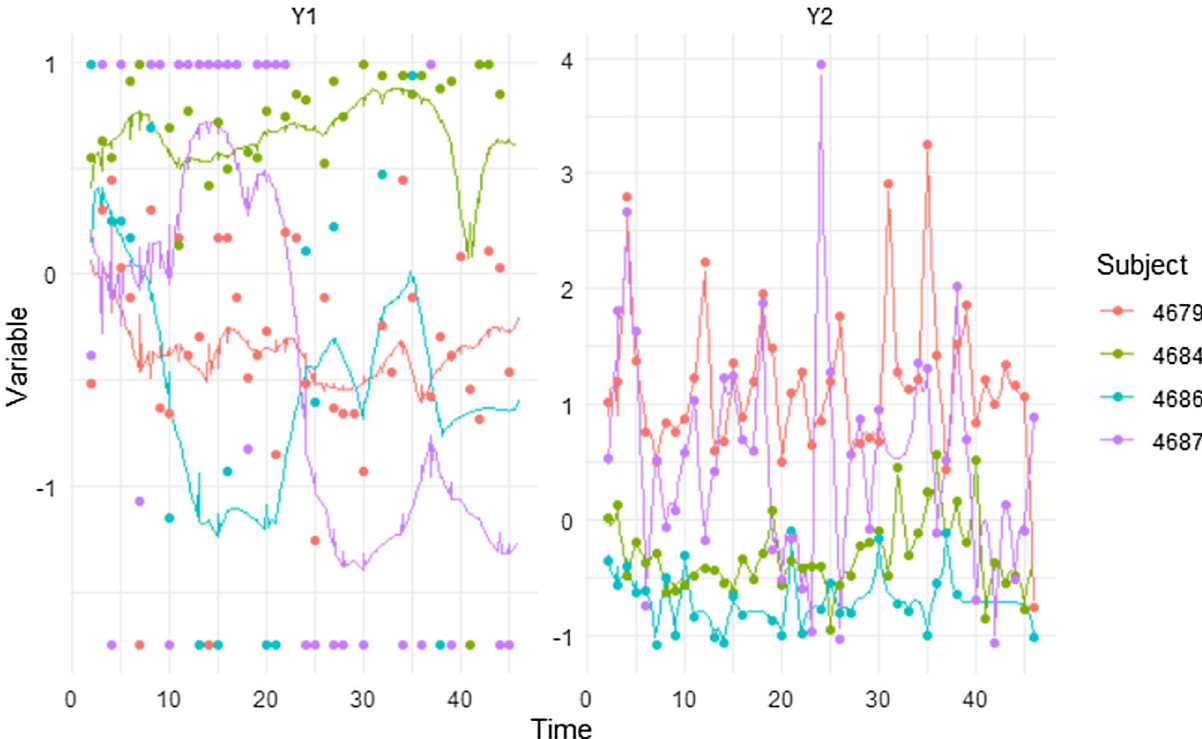
Figure 3. Observed data points of well-being (Y1) and frequency of use (Y2) for four specific subjects over 44 days. Auto-effects of Y1 are more stable over time, whereas Y2 showed more variation.